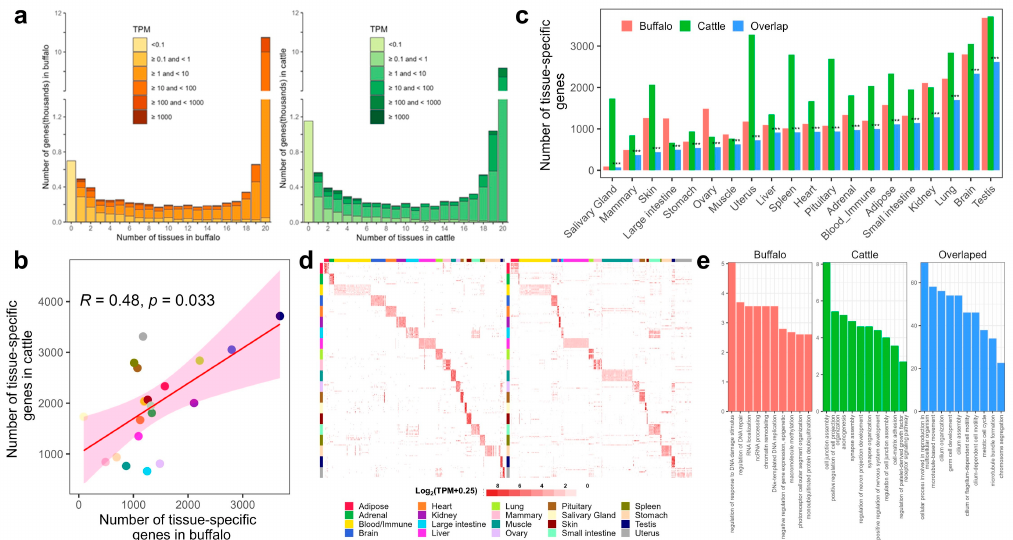
Figure 3. Comparison of tissue specificity of gene expression. ( a ) Gene expression levels and the number of tissues in which genes were expressed (median TPM > 0.1) in buffalo ( left ) and cattle ( right ). ( b ) Spearman’s correlation of a number of tissue-specific genes across tissues between buffalo and cattle. Each dot represents a tissue. ( c ) A number of tissue-specific genes (log 2 (fold-change) > 1.5 and FDR < 0.05) and their overlap across 20 tissues in buffalo and cattle (*** p < 0.001). ( d ) Expression profiles of top 10 tissue-specific genes that are detected in buffalo among both buffalo ( left ) and cattle samples ( right ). Each row represents a gene, and each column represents a sample from the corresponding tissue. The color represents log 2 -transformed expression value (log 2 (TPM + 0.25)). ( e ) Top 10 significantly enriched GO terms for tissue-specific genes (uniquely in buffalo or cattle and overlapped between buffalo and cattle) in